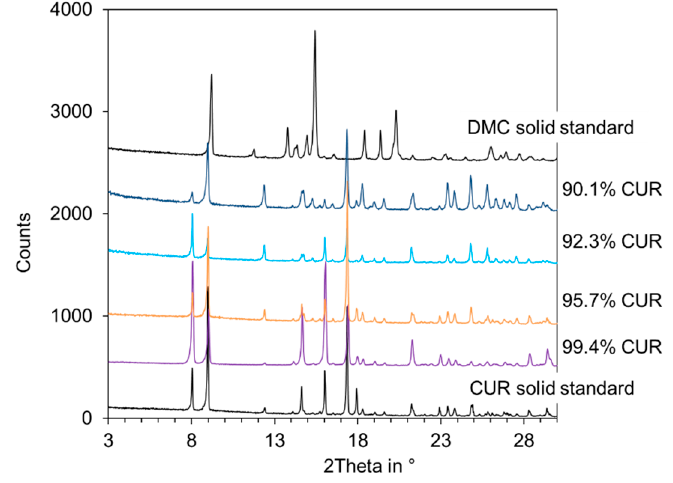
Figure 8. XRPD patterns of four crystallization products with increasing CUR content.